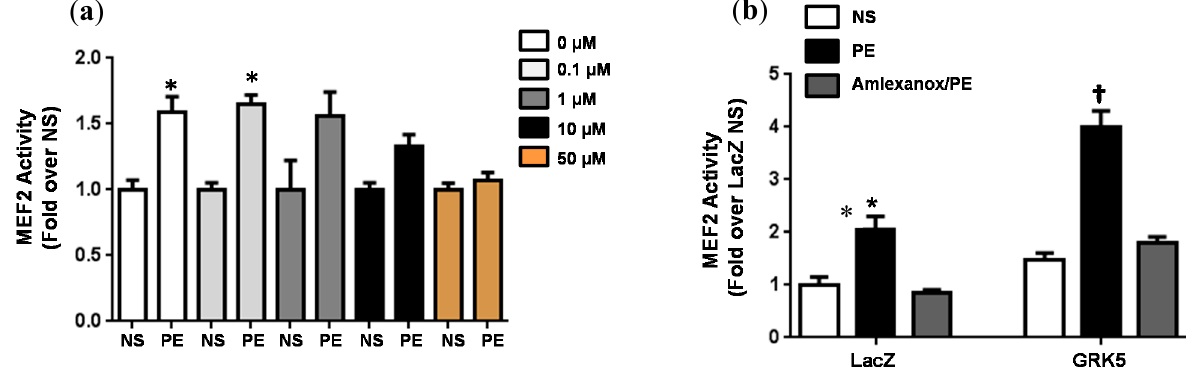
Figure 3. MEF2 activity in NRVMs measured using a luciferase assay system. ( a ) Cells were infected with an adenovirus expressing a MEF2-luciferase (Ad-MEF2-Luc) reporter construct for 48 h. Following infection, the cells were either not stimulated (NS), or stimulated for 24 h with phenylephrine (PE, 50 µM) or with both PE and amlexanox at different doses (0 µM, 0.1 µM, 1 µM, 10 µM and 50 µM). * p < 0.05 vs. NS, as assessed by one-way ANOVA with a Bonferroni correction. ( b ) Cells were co-infected with the Ad-MEF2-Luc and either Ad-LacZ or Ad-GRK5 and then incubated with or without 50 µM PE for 24 h or with both 50 µM amlexanox and PE. * p < 0.05 vs . LacZ NS, † p < 0.001 vs. all, as assessed by one-way ANOVA with a Bonferroni